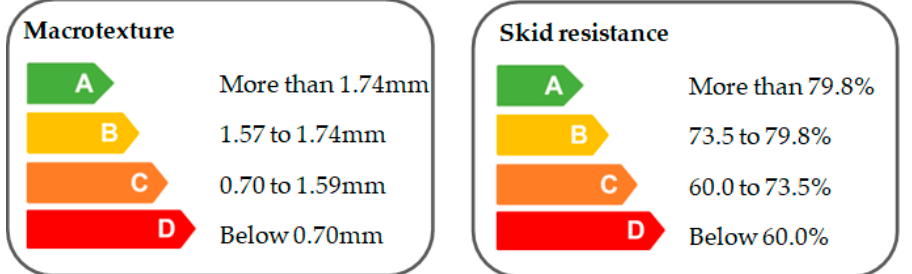
Figure 21. Macrotexture and skid resistance global label.